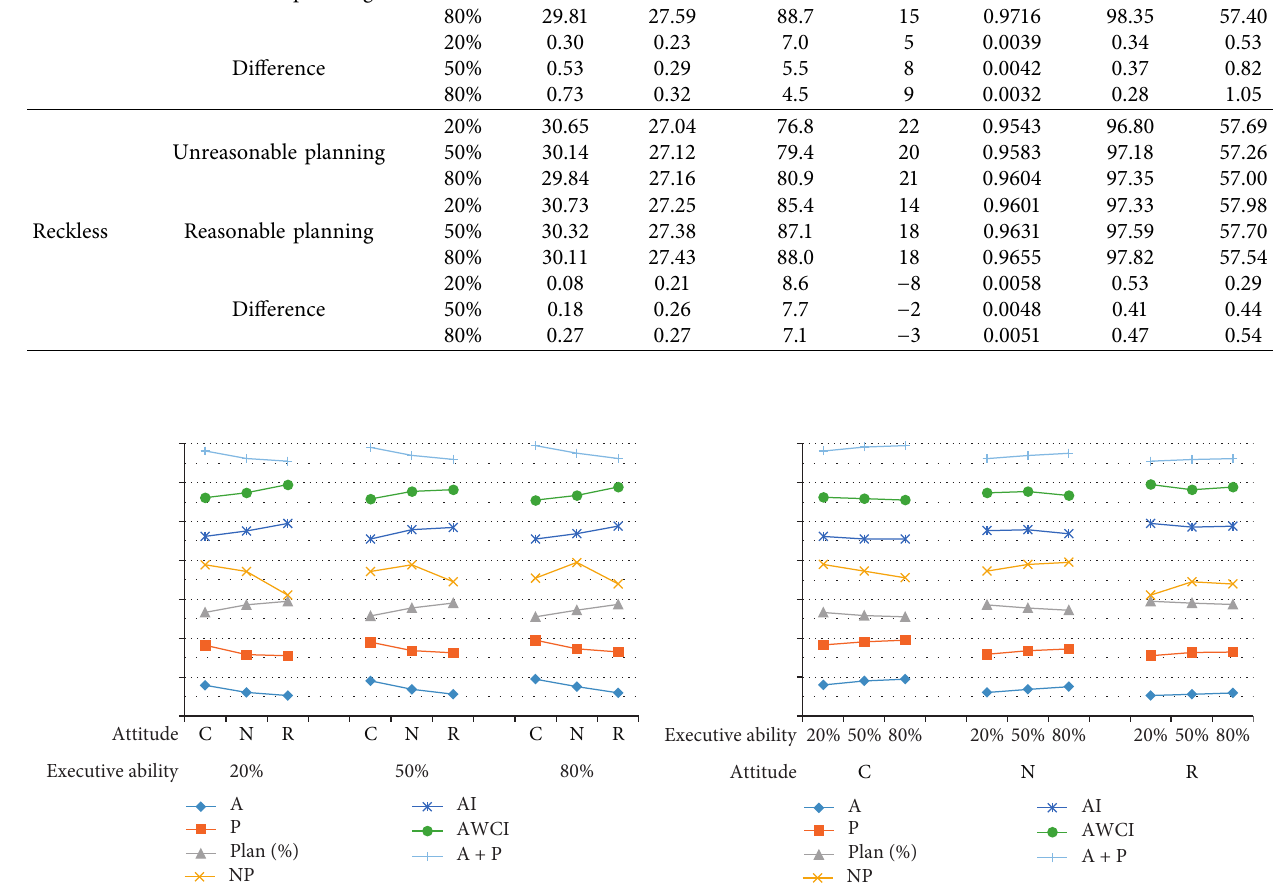
Table 5: Comparison between results of urban development in the situations of reasonable planning and unreasonable planning. Attitude Unreasonable planning Cautious